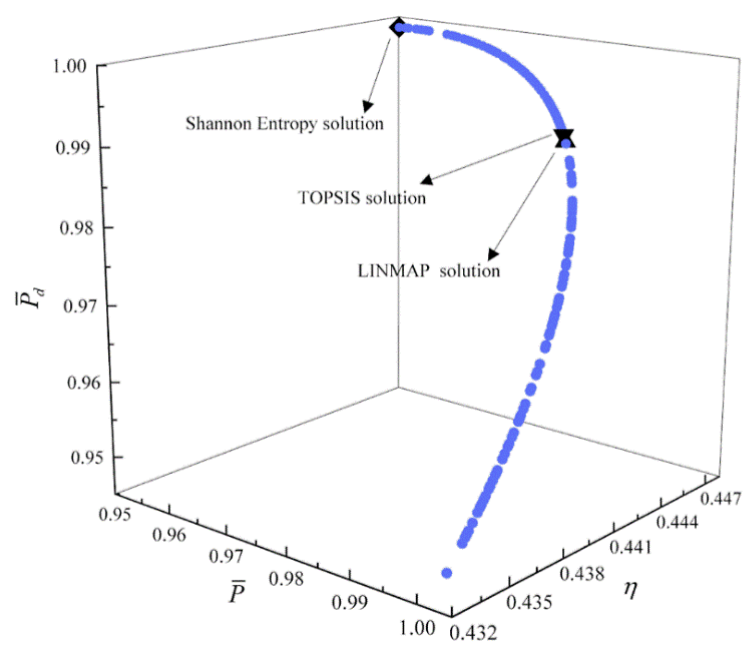
Figure 11. Tri-objective optimization on P − η − E .